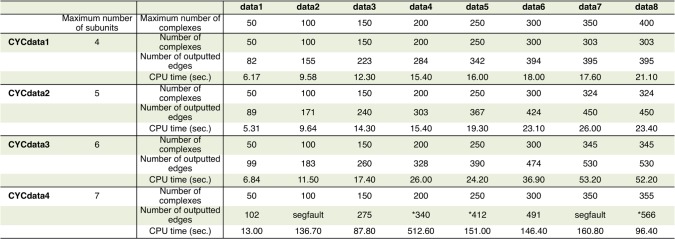
Performance comparison of ILPMinPPI with four protein complex datasets.Summary of four real protein complex datasets from CYC2008 and performance comparison of ILPMinPPI with these datasets. For example, ‘data7’ of CYCdata1 is composed of 303 complexes (see ‘Number of complexes’), where the number of subunits is at most 4 (see ‘Maximum number of subunits’). When using this data, ILPMinPPI outputs 395 edges and requires 17.6 seconds. A ‘segfault’ refers to the segmentation fault which occurs when a program accesses an invalid memory address and the number of outputted edges with asterisk(*) means that CPLEX outputs not an optimal solution but a feasible solution because of exceeding the memory limit.